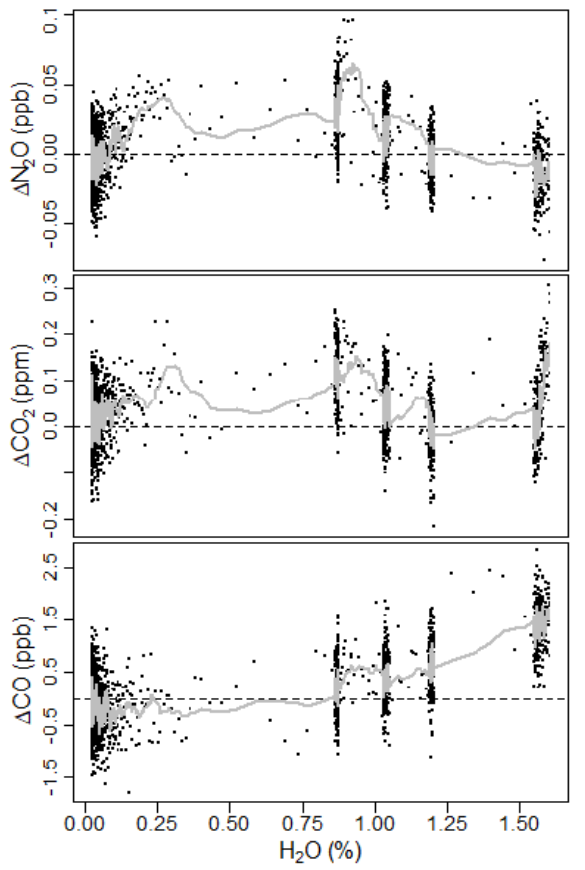
Figure 3. Residual uncertainty in water vapor correction for N 2 O, CO 2 , and CO with broadening coefficients of 1.33, 1.93, and 1, re- spectively. Black dots are the deviation from the dry value, with a moving average (10s) depicted in gray.